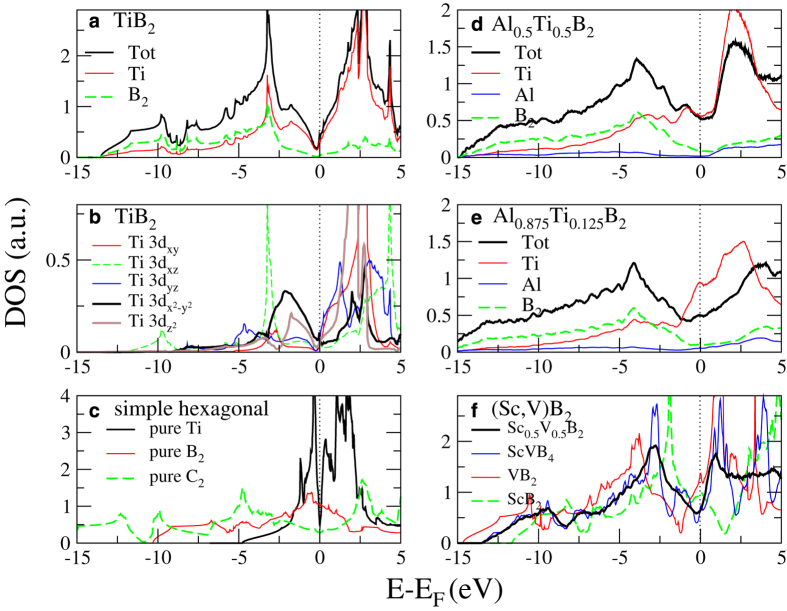
a) Total electronic DOS and b) symmetry projected Ti d-states of TiB2. c) Ti DOS of simple hexagonal structure without B, and B2, and C2 DOS without Ti. d) DOS of Al0.5Ti0.5B2, e) DOS of Al0.875Ti0.125B2, f) DOS of (Sc,V)B2 alloys.